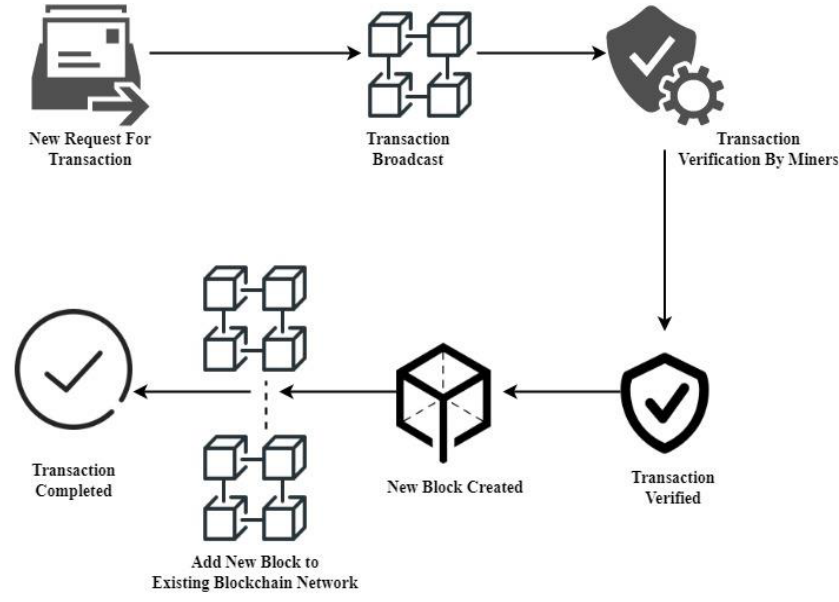
Figure 2. Blockchain